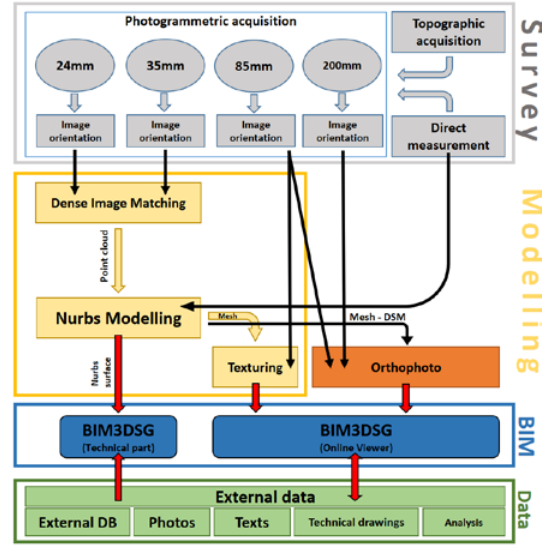
Figure 7: Pipeline of the project from the survey part, through the modelling part, to the orthophoto creation and the use of BIM3DSG system as catalyst of